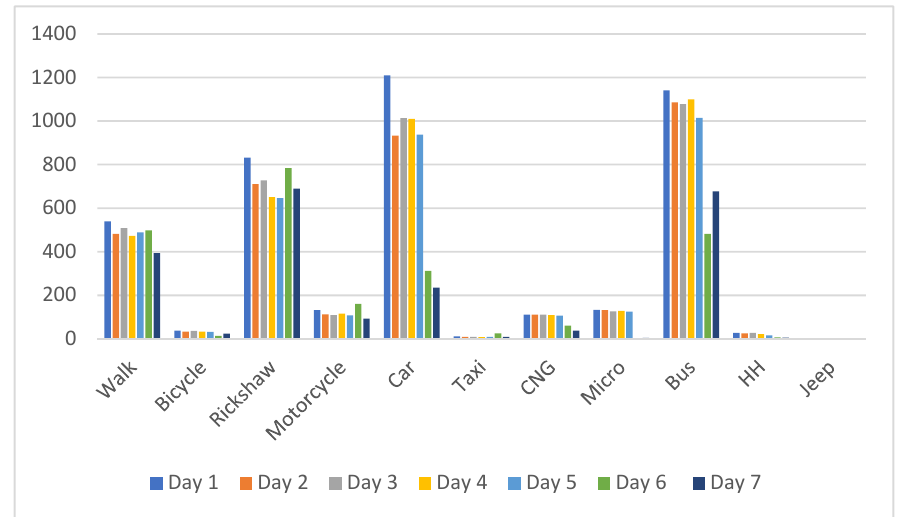
Figure 7. Day-wise modal frequency by number of passengers in different travel modes. HH: human hauler.